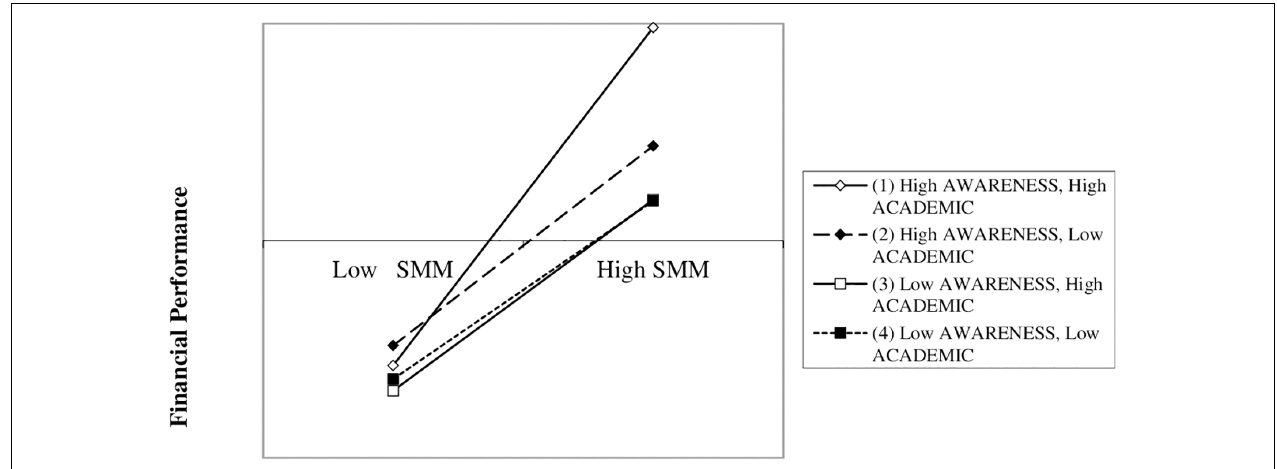
FIGURE 5 | Three-way interaction. SMM * AWARENESS * ACADEMIC. AWARENESS, brand awareness, as the goal of the company; ACADEMIC, academic background of the female entrepreneur; SSM, social media marketing, how intensely the company implements Social Media Marketing